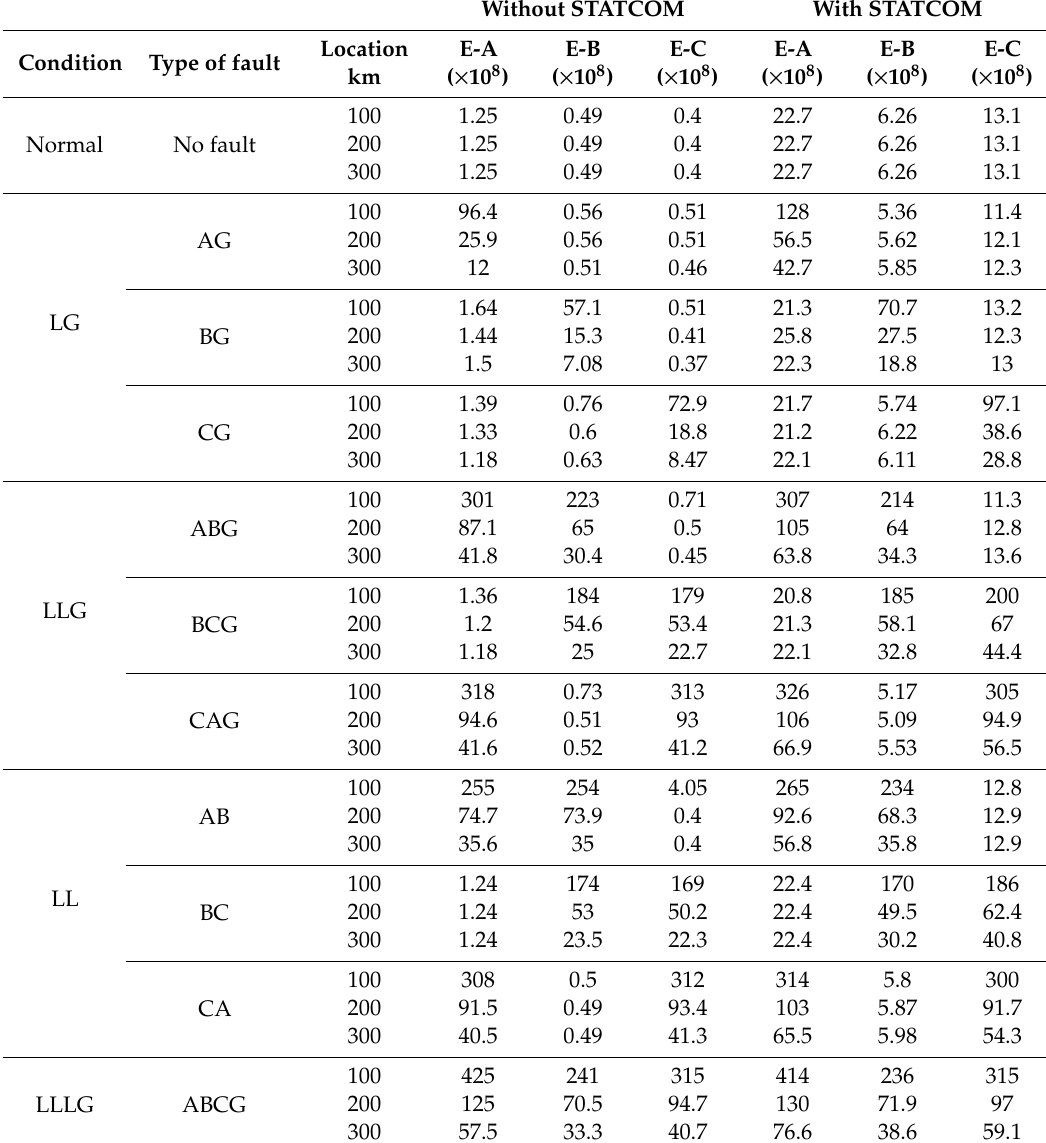
Table 6. Energy-based feature values for